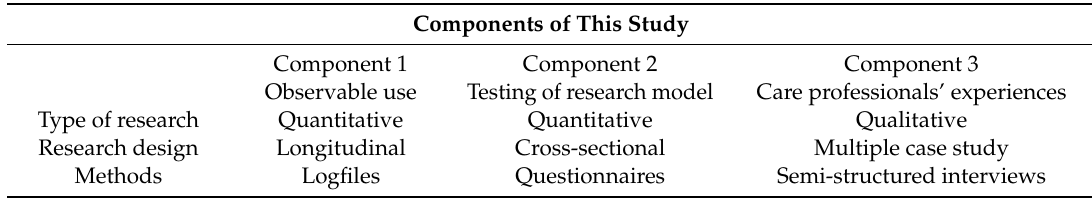
Table 1. Summarized overview of the research